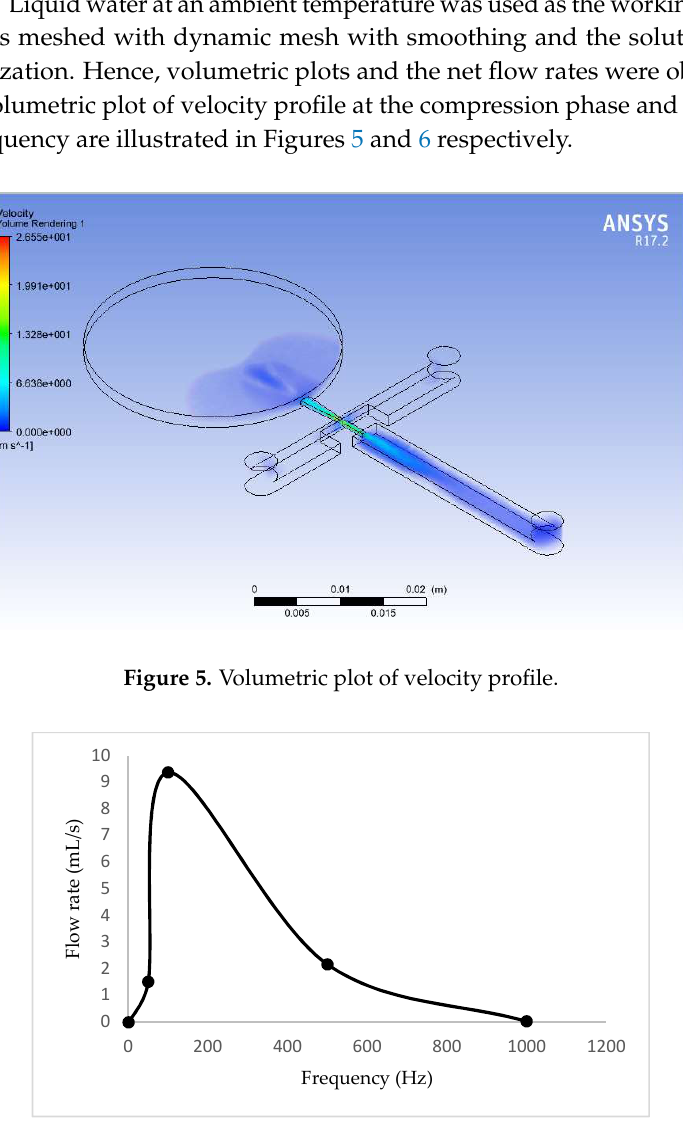
Figure 6. Variation of net flow rates with the frequency.